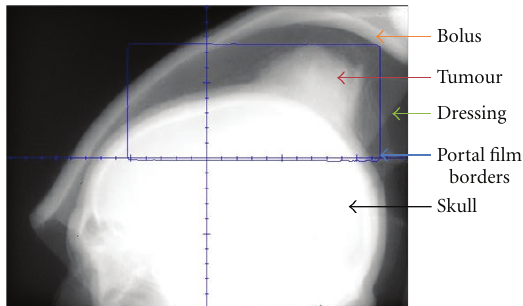
Figure 1: Lateral port film showing bolus, dressing, and the lesion. In this image, the beam irradiates the tumour with the dressing in place. Short course radiotherapy of 20 Gy in 5 fractions was used for the initial part of treatment.